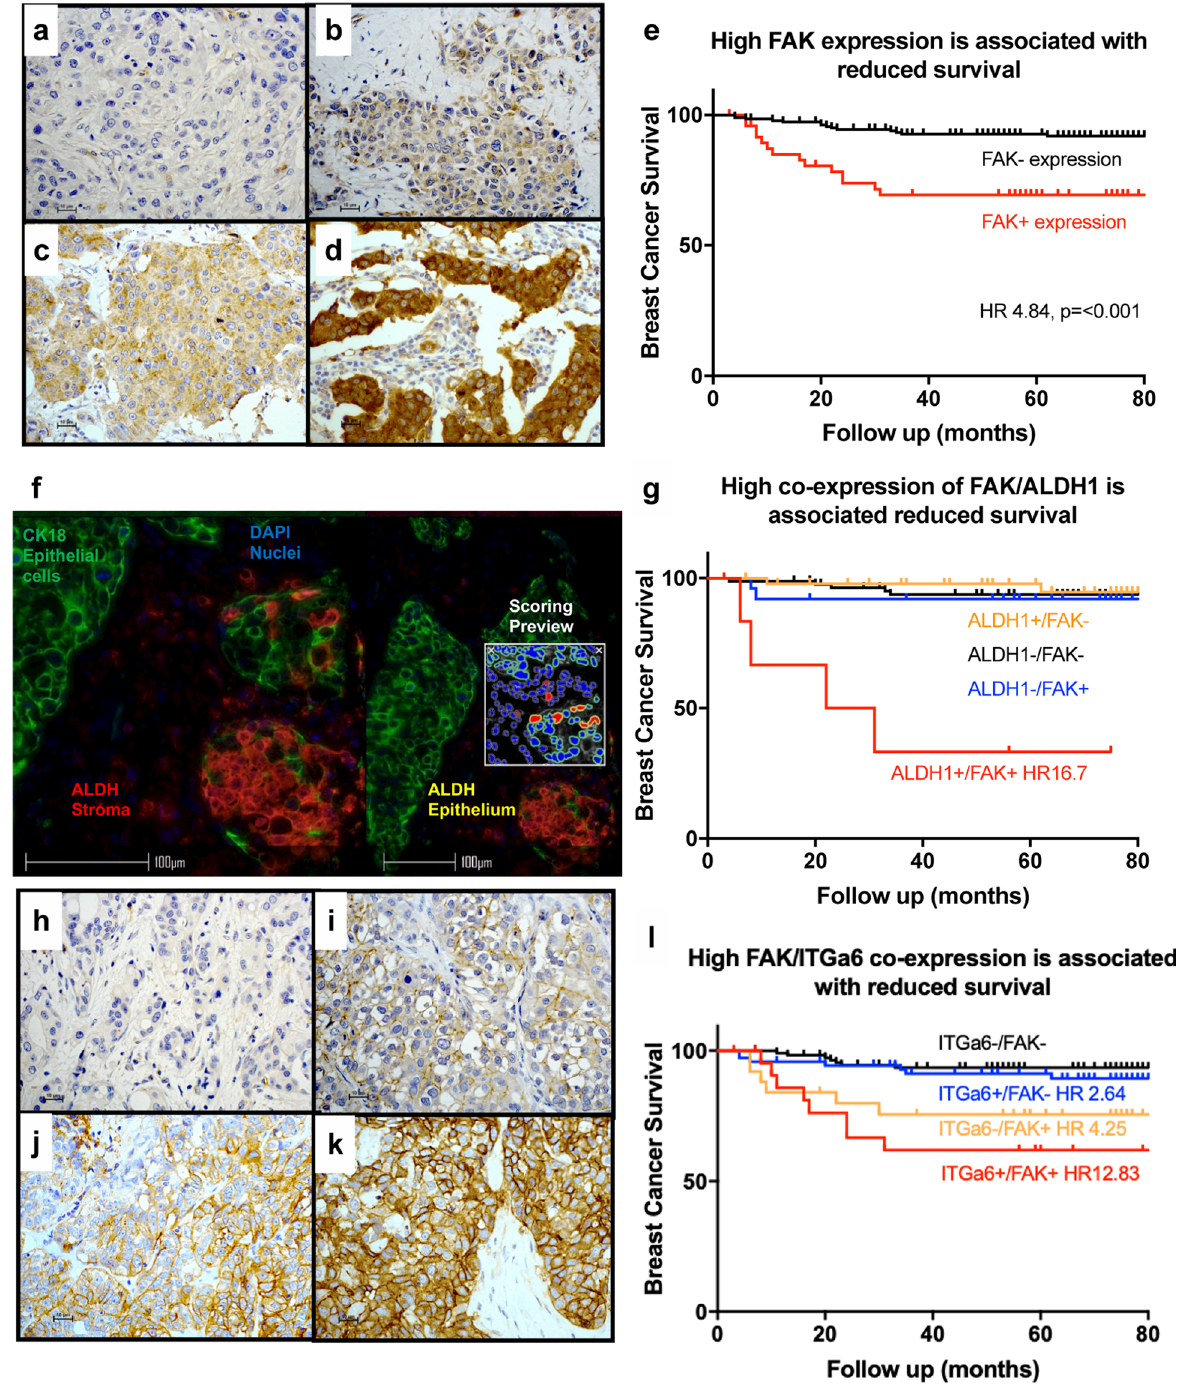
Fig. 4 High FAK and high FAK/ALDH1 or FAK/ITG α 6 expression is associated with reduced breast cancer survival. Representative photomicrographs of FAK staining taken at ×40 magni fi cation with 10 µM scale bars demonstrating; a no staining, b weak staining, c moderate staining, and ( d ) high staining. High FAK expression was de fi ned as high intensity staining in greater than 20% of epithelial cells as per Yom et al. criteria. e Kaplan – Meier demonstrating high FAK was associated with reduced survival, HR 4.84 (2.33 – 10.04, Cox-proportional regression p < 0.001). f Representative photomicrograph, with 100 µM scale bar of immuno fl uorescence staining with epithelial cells isolated using a CK18 antibody conjugated with a green fl uorophore and ALDH1 conjugated to a red fl uorophore. Automated analysis of dual